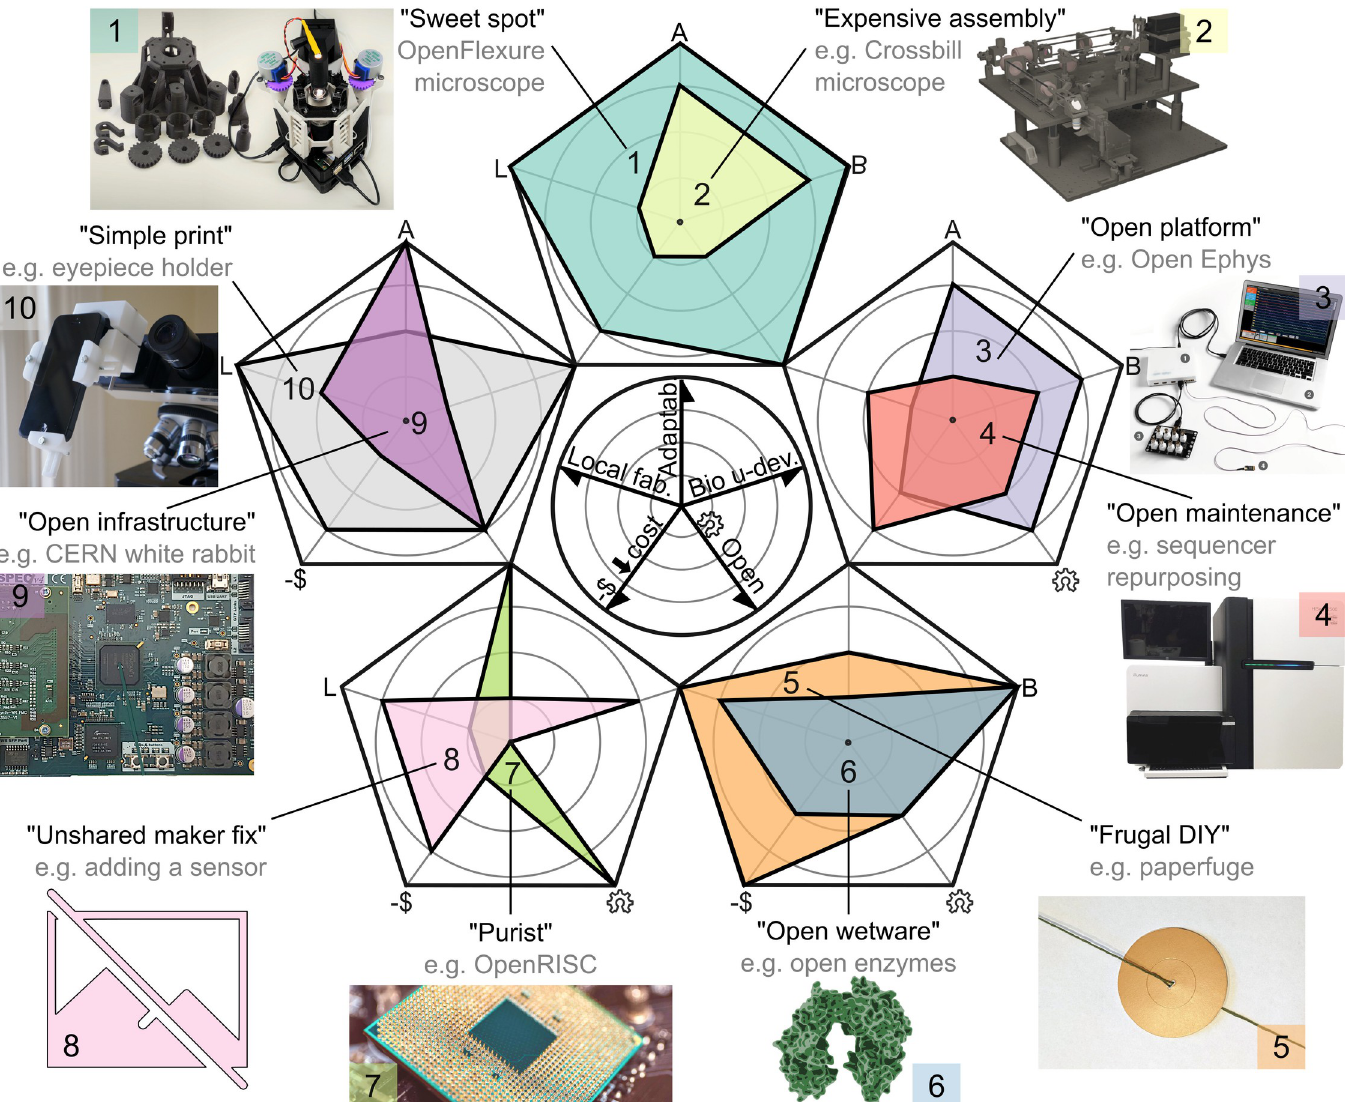
Fig 2. Ten types of open hardware. A range of projects falls within the portfolio of open hardware in a research context. Ten types (sweet spot, expensive assembly, open platform, open maintenance, frugal DIY, open wetware, purist, unshared maker fix, open infrastructure, and simple print) are conceptualized and rated in radar charts along five dimensions (see scale in the center): local fabrication suitability (can components be fabricated almost anywhere?); adaptability of the design; suitability for life science users to interact with the project documentation and contribute as developers; availability of modifiable open source design files; and to what degree needed components are low cost. The selected dimensions were rated subjectively on a scale from 0–4 to differentiate types of open hardware in general, not only the given examples [19–23]. See Box 2 for further explanation.